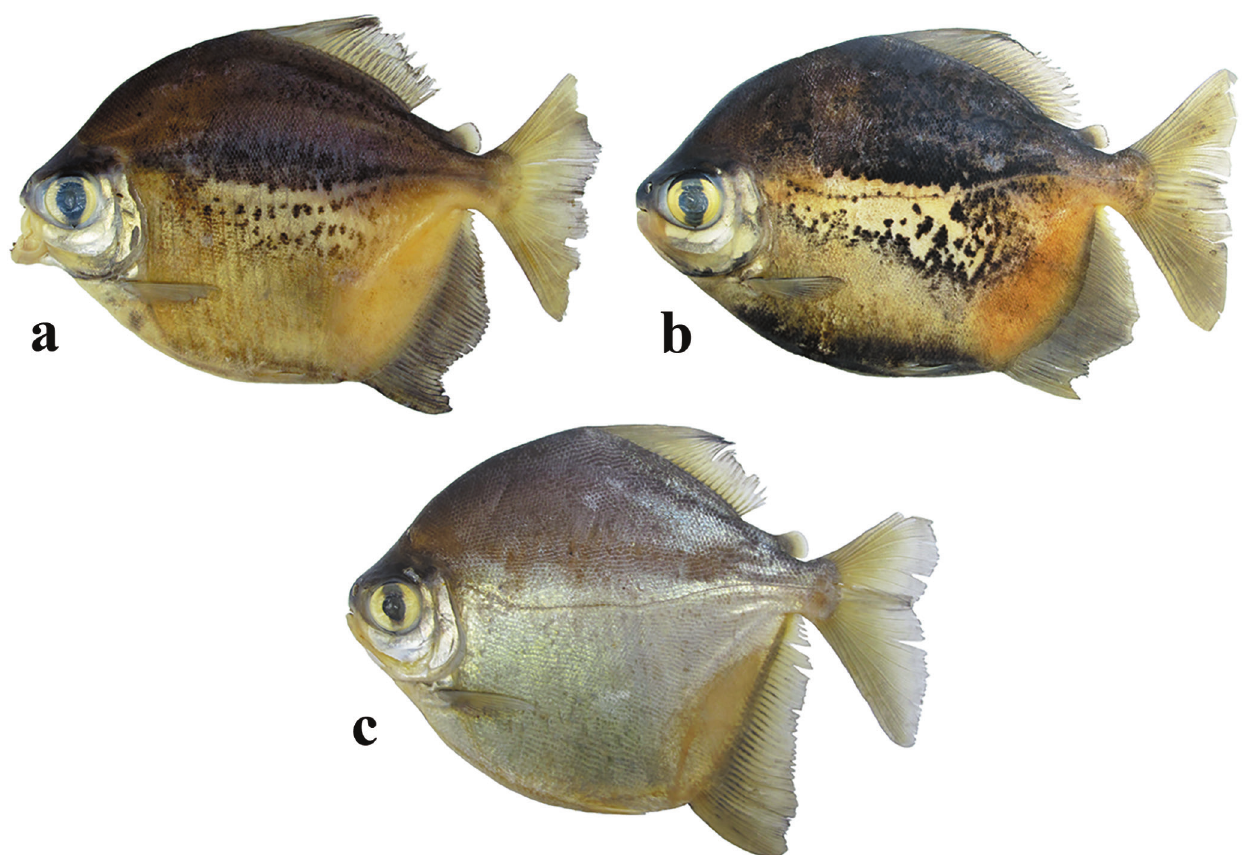
Fig. 1. Myloplus taphorni : Guyana, Essequibo Basin. a. Holotype, CSBD F 3611, male, 143.3 mm SL; Paratypes, b. UMMZ 251911, male, 154.9 mm SL, and c. ROM 101262, female, 142.4 mm SL. Photos: MCA.